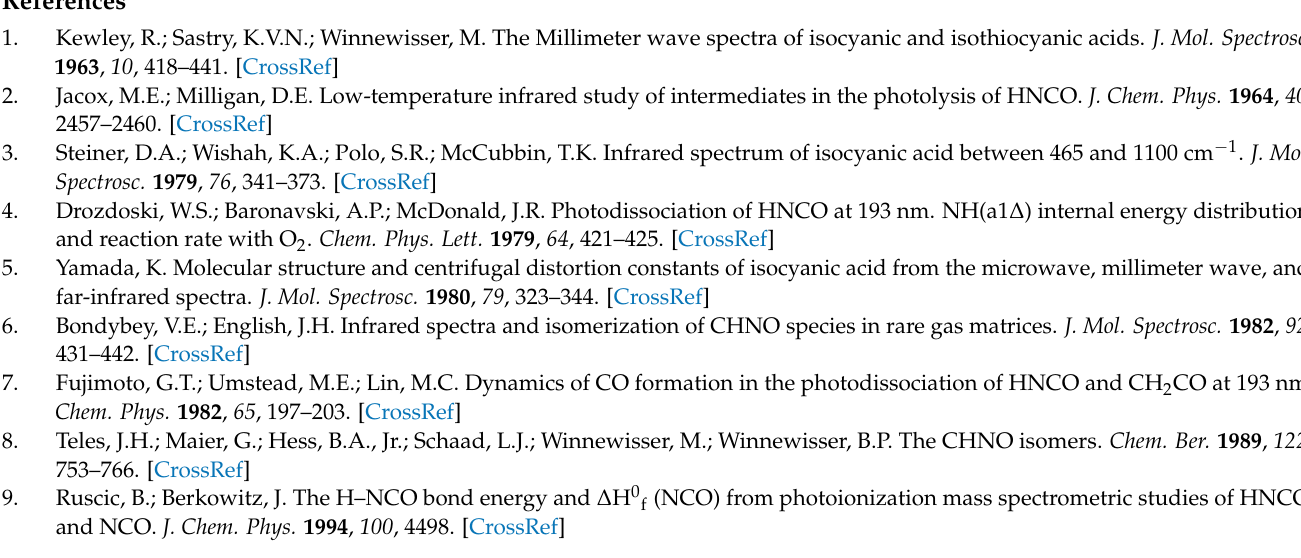
Table S7: Theoretical infrared wavenumbers ( υ , cm − 1 ) and intensities (I, km mol − 1 ) for 2:1